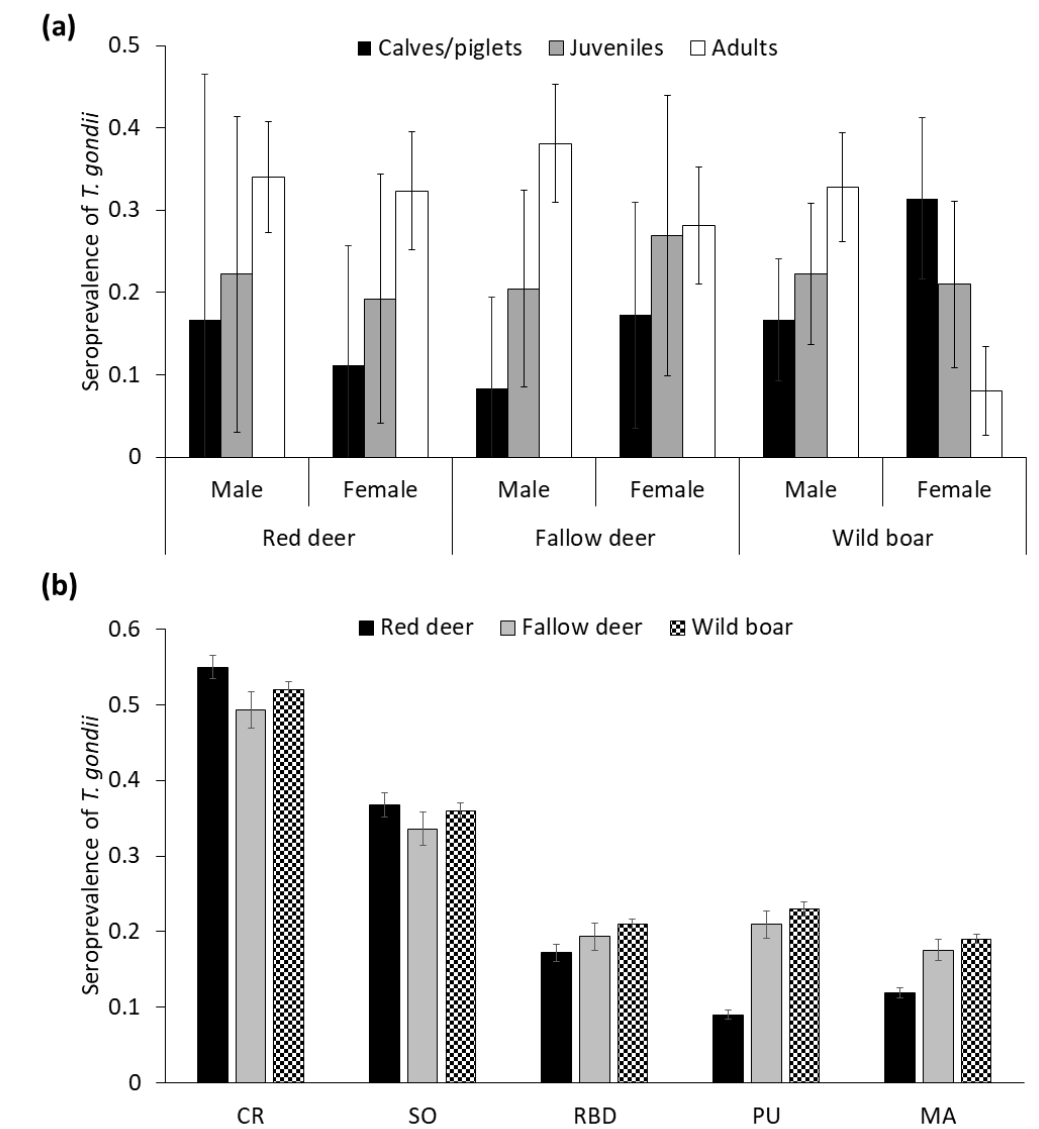
Figure 2. ( a ) Seroprevalence ( ± CI 95%) of Toxoplasma gondii depending on age class and sex in red deer, fallow deer and wild boar ( b ) Seroprevalence ( ± CI 95%) of T. gondii obtained from selected generalized linear mixed models (GzLMMs) for the species studied depending on the sampling area, from north to south areas (see Figure 1 for a map of the areas with their full names).